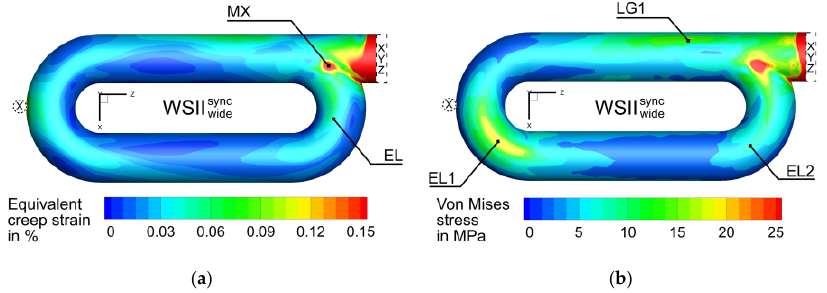
Figure 9. Results for case VI showing: ( a ) creep strain; ( b ) stress distribution (burner-on point).